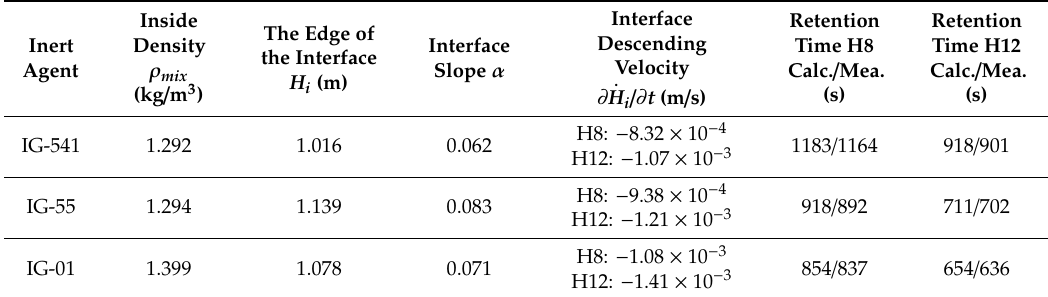
Table 5. Summary of experimental results for each inert